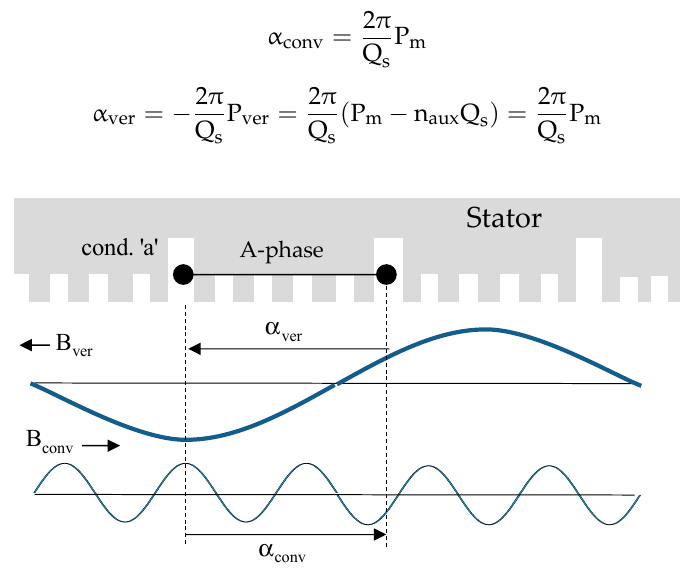
Figure 2. Slot angles for both flux waves.